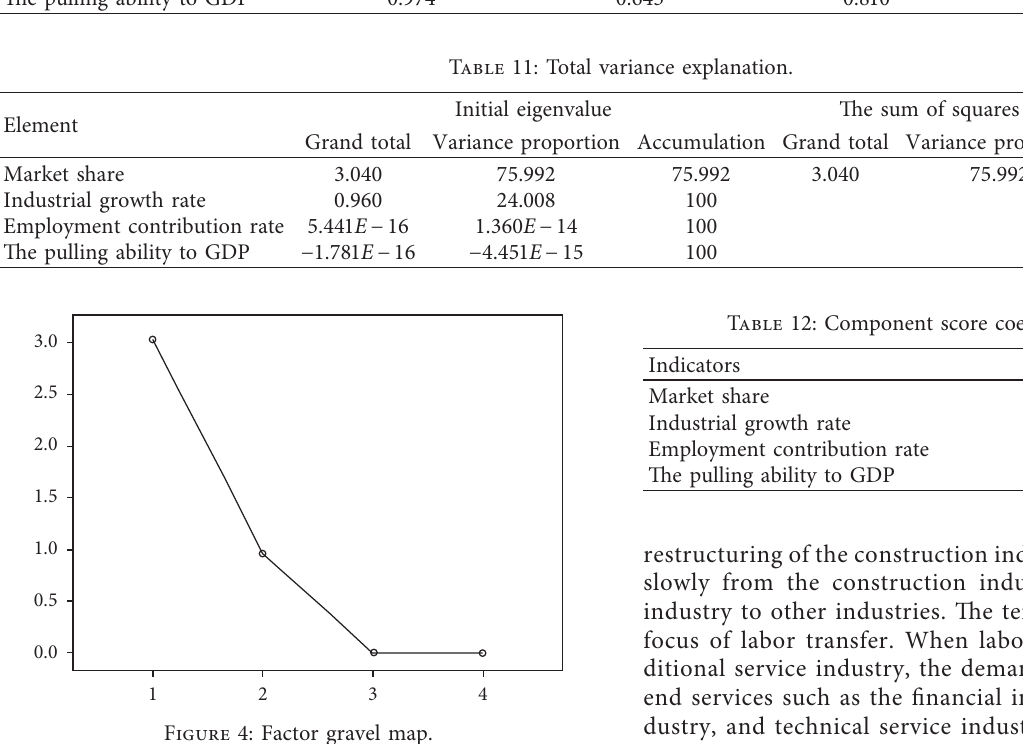
Figure 4: Factor gravel map.